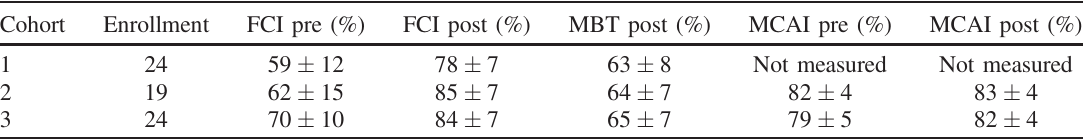
TABLE I. Class-average percentage scores (reported with margins of error at 95% confidence) on standard PER instruments. Pairwise deletion was used so that pre- and post-test averages for the same assay represent the same subset of students.